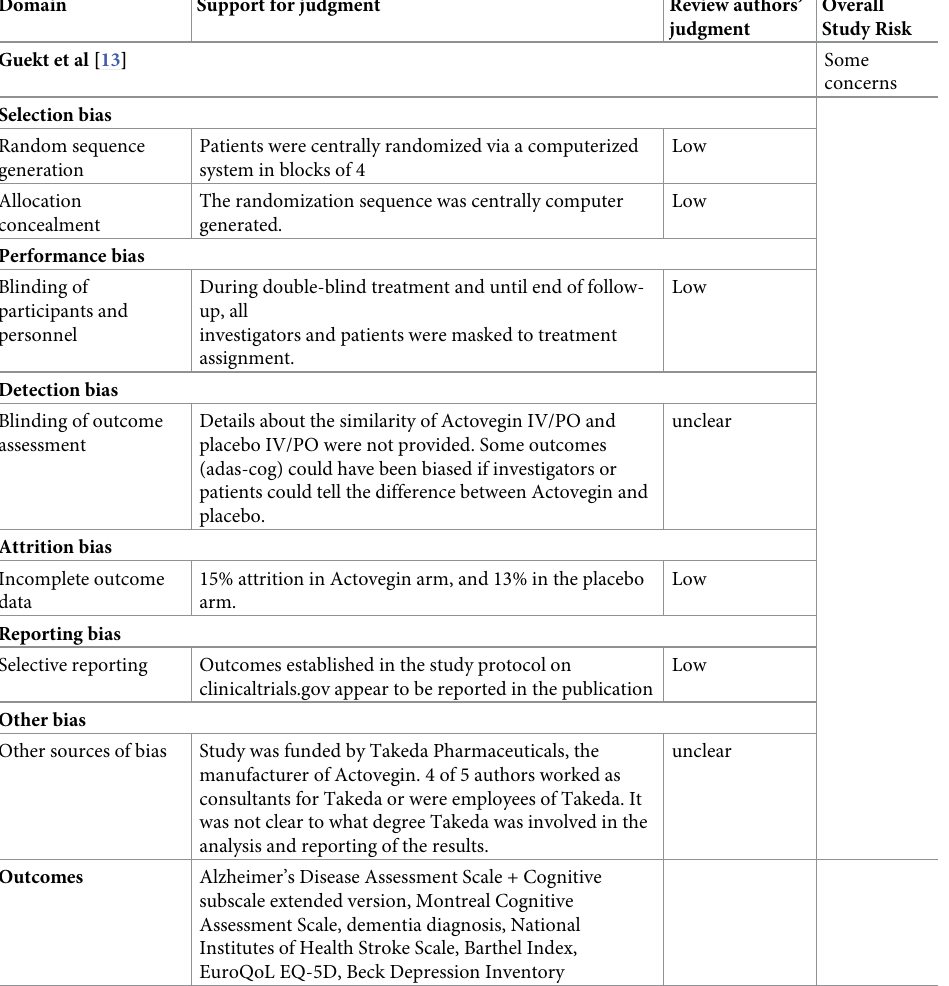
Table 4. Risk of bias assessment for the included randomized controlled trials.